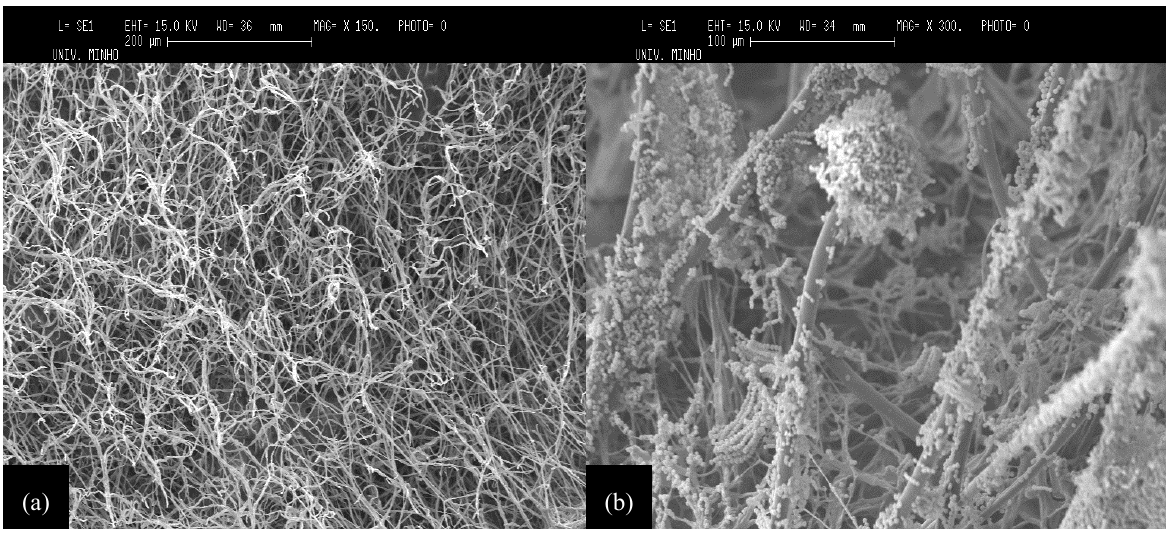
Figure 3. Microphotographs obtained by SEM for orange peel supports colonised by Aspergillus niger strain URM 5162: ( a ) support with 4 days of incubation at 25 °C (×150) and ( b ) support with 7 days of incubation at 25 °C